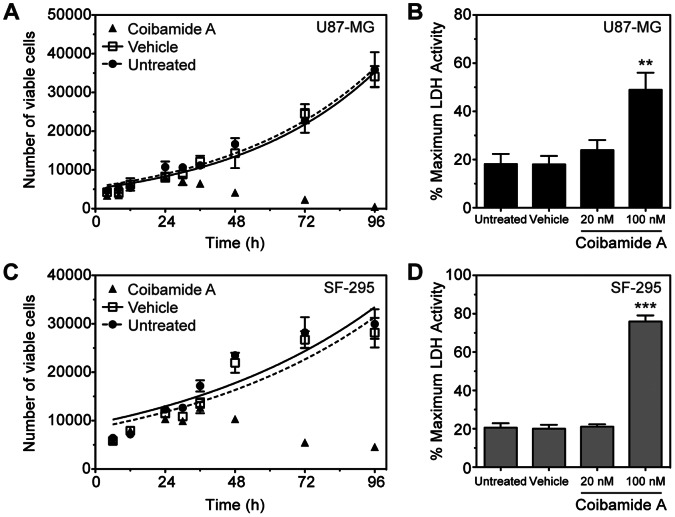
Coibamide A induces a time- and concentration-dependent decrease in plasma membrane integrity.(A) Trypan Blue exclusion test of cell viability in U87-MG cultures treated with or without coibamide A (20 nM) or vehicle (DMSO) over 4 days. (B) Concentration-response relationship of LDH efflux in U87-MG cells treated with or without coibamide A or vehicle for 4 days (C) Trypan Blue exclusion test of cell viability and (D) concentration-response relationship of LDH efflux in SF-295 cells treated with or without coibamide A or vehicle (as above) for 4 days. Trypan Blue exclusion profiles represent mean cell counts ± SD of a representative time course performed in triplicate and repeated at least three times in each cell line. Histograms represent mean LDH efflux ± SE of at least three independent experiments performed in triplicate (**P<0.01 and ***P<0.001, coibamide A vs. untreated control).